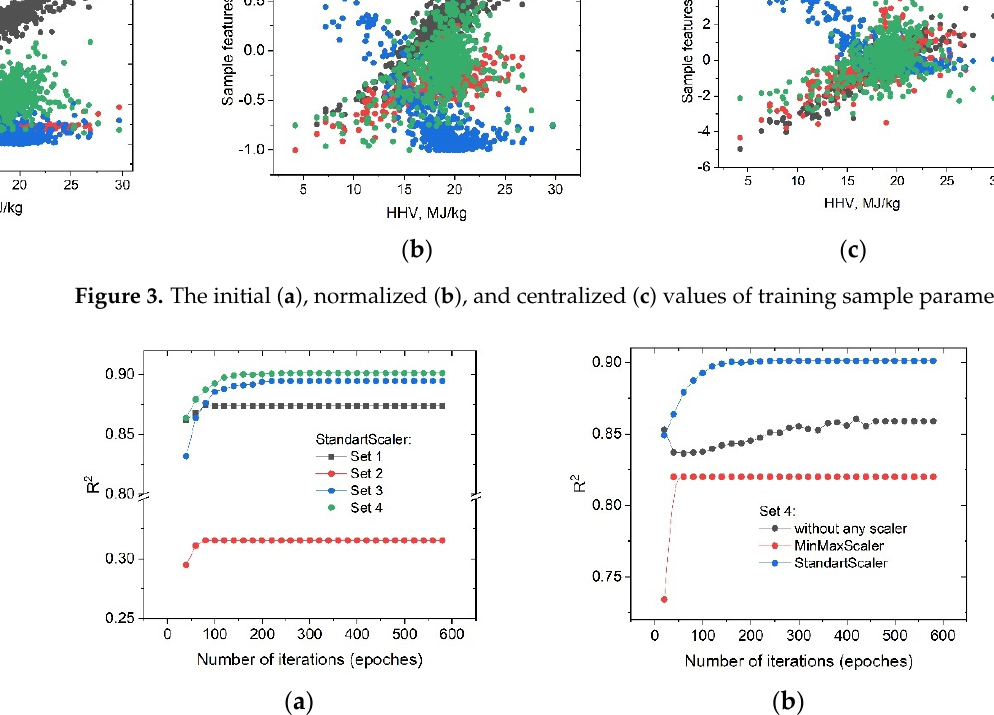
Figure 4. The effect of the number of iterations ( a ) and preprocessing ( b ) on prediction accuracy of